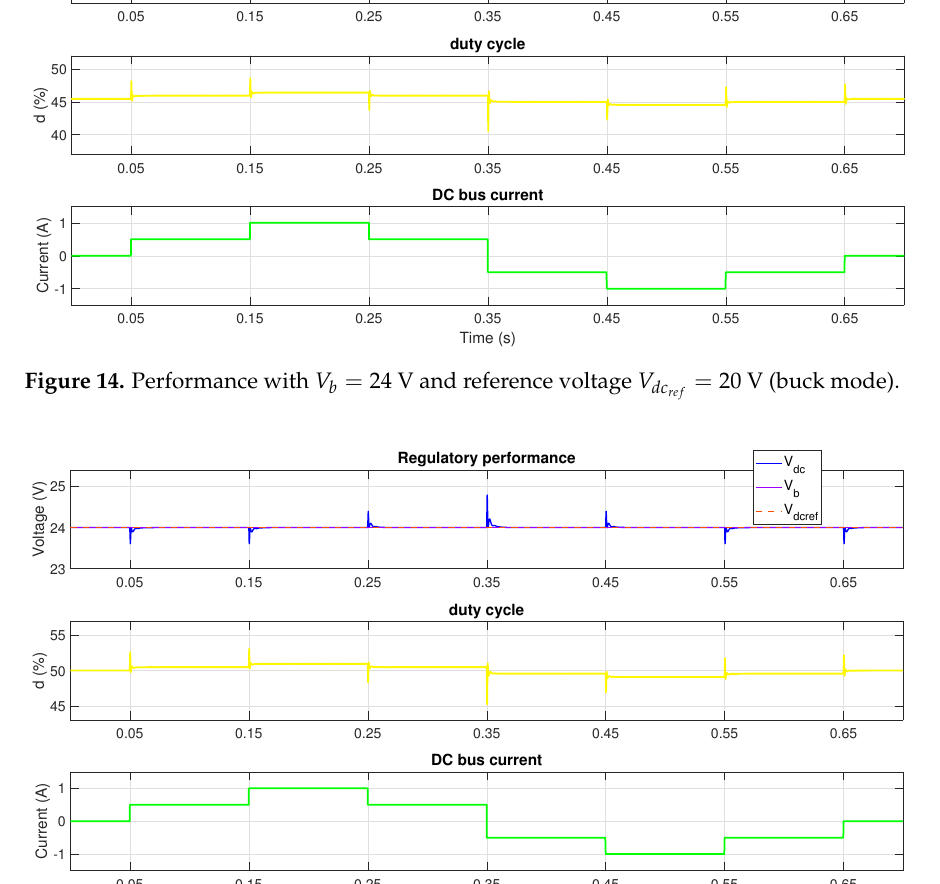
Figure 15. Performance with V b = 24 V and reference voltage V dc